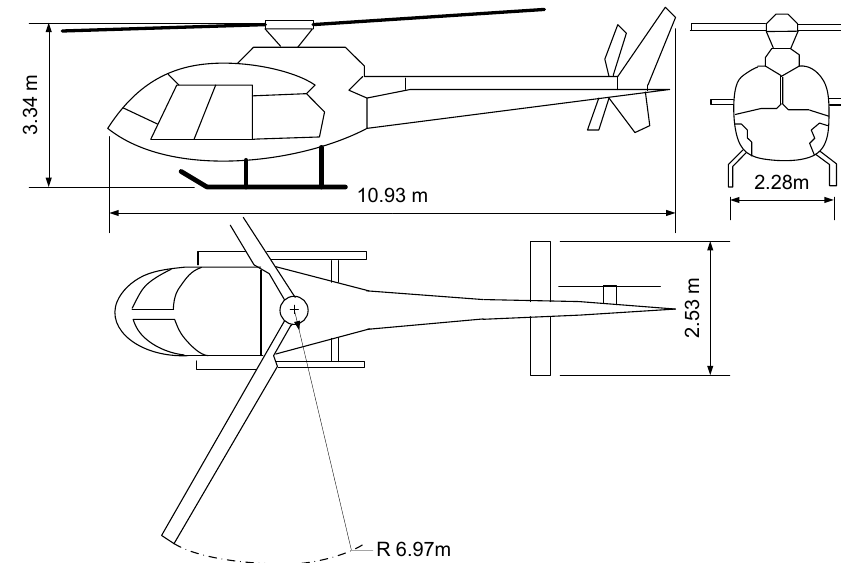
Figure 1. Eurocopter Fennec.